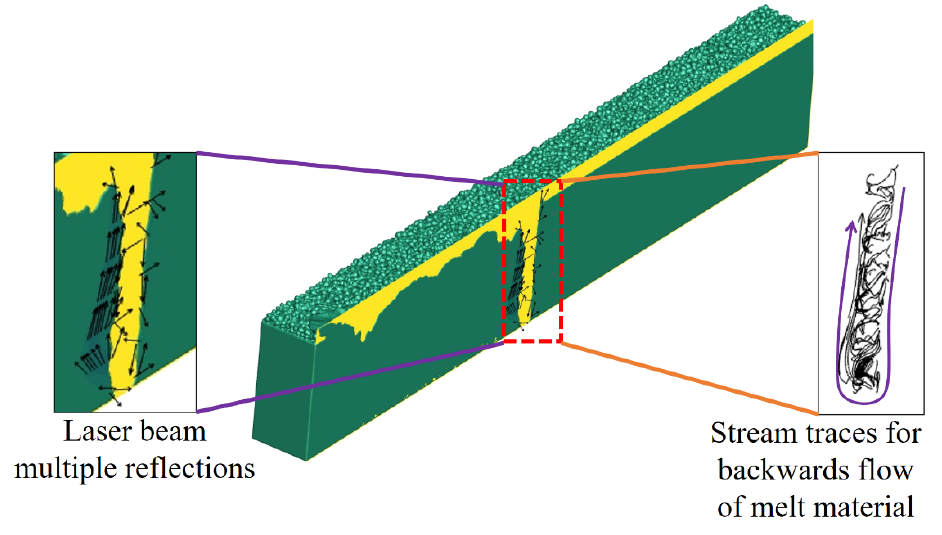
Figure 9. Stream traces and laser beam multiple reflections in deep keyhole melt flow mode.